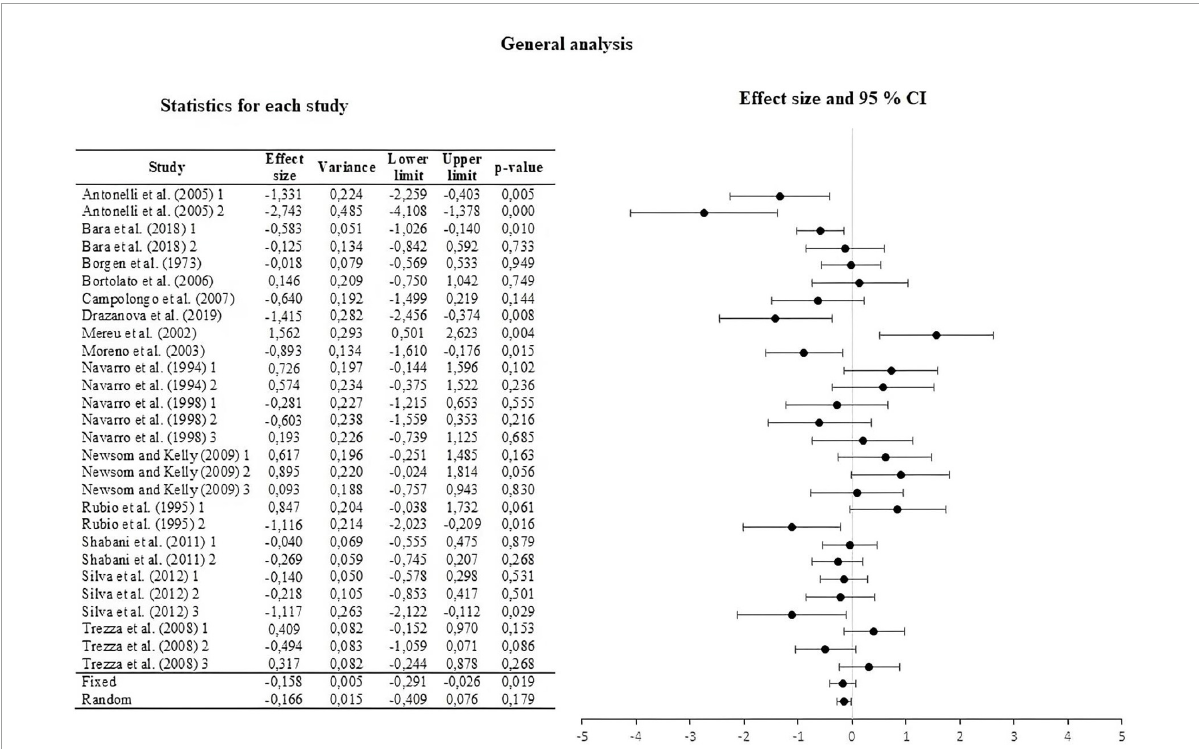
FIGURE2 Forest plot of the effect sizes and estimated confidence intervals of all Unit of Analysis (UA). For the integrated effect size Cohen’s d was used. The lines indicate the effect sizes of each UA and its corresponding 95% confidence intervals. The last two lines represent the result under a fixed and random effect model, respectively. The lower and upper limits, the p -values and the variance of each UA are